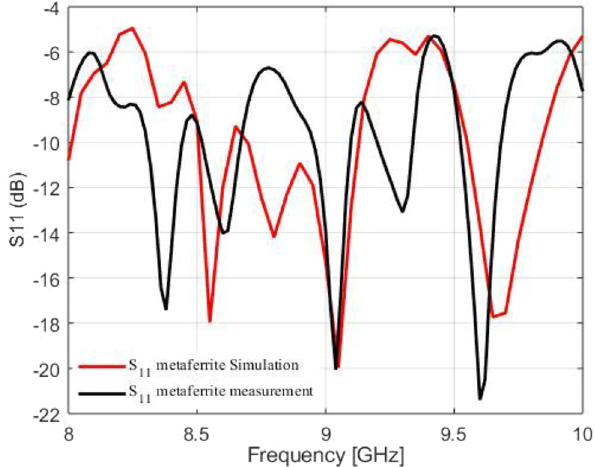
Fig. 5. Simulated and measured re fl ection coef fi cient S 11 of the U-slot patch antenna with metaferrite material.